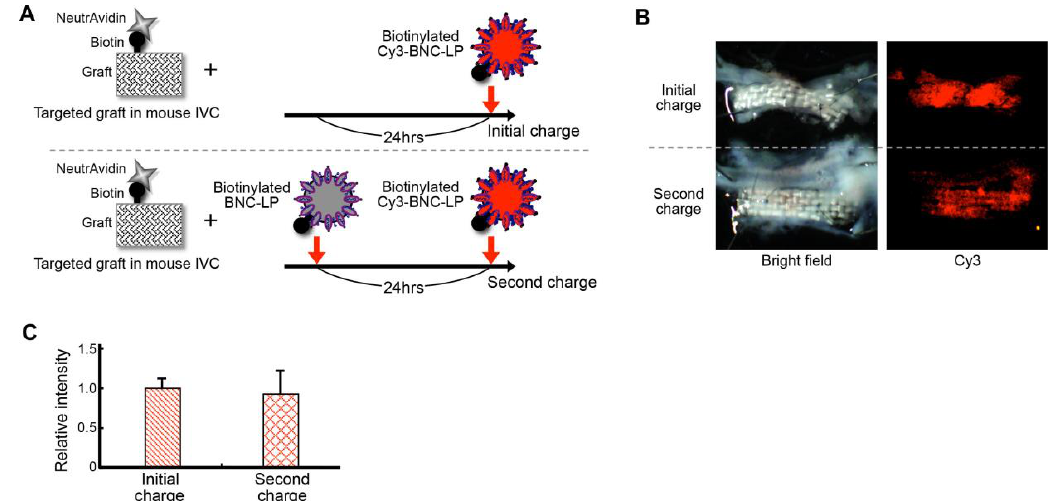
Figure 7. Efficient recharging of the targeted graft with the target-recognizing BNC-LP complex in vivo. ( A ) Schematic diagram of the experiment: an initial charge is compared to a second charge (recharge). ( B, left) Bright field images show the grafts excised from mice after the experiment. (Right) Fluorescence images show the accumulation of Cy3-labeled BNC-LPs on both targeted grafts. ( C ) Efficiency of recharging the targeted graft with the BNC-LP complex, determined by measuring relative fluorescence intensities. Data are the means ± standard deviations of 3 independent observations.